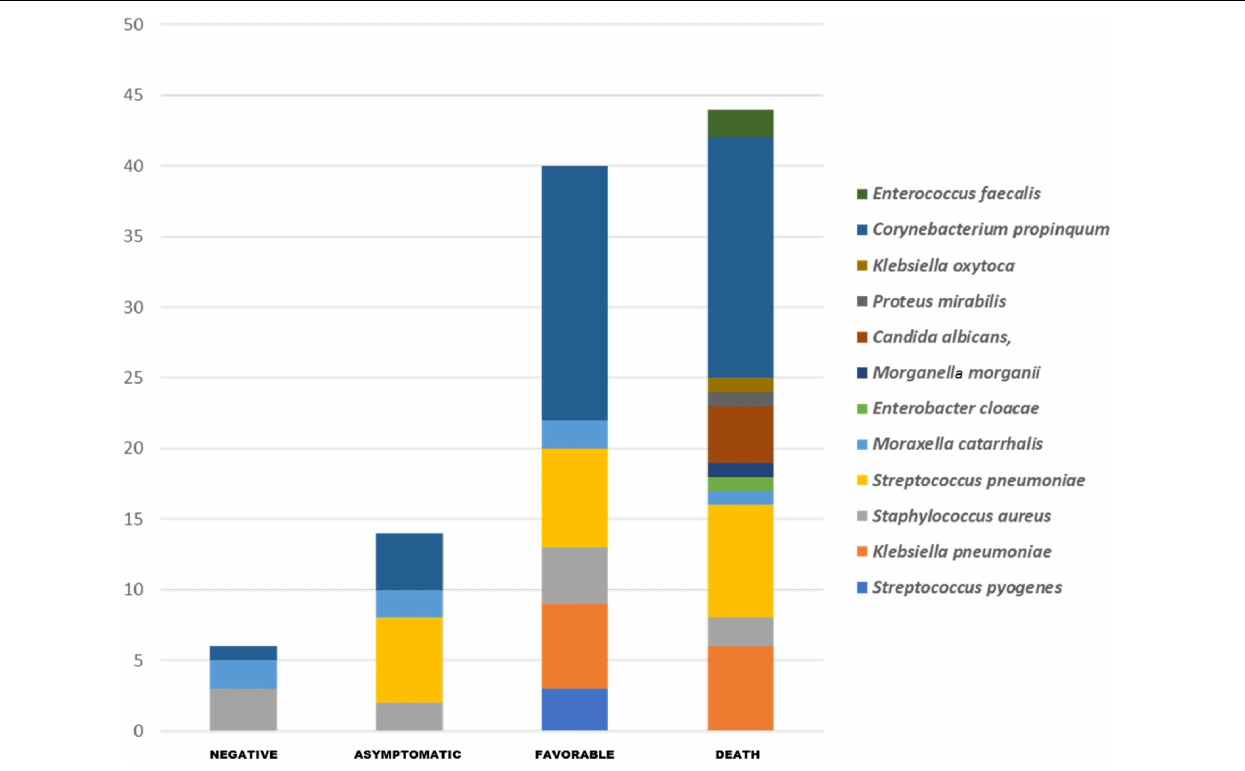
FIGURE 4 | All respiratory pathogens routinely detected in our COVID-19 patients and by specific PCR. The pathogenic bacteria PCR shows the significant enrichment of Streptococcus pneumoniae ( p ≤ 0.01) and Corynebacterium propinquum ( p ≤ 0.000006) in the group of COVID-19 positive patients, and Klebsiella pneumoniae ( p ≤ 0.01) in deceased patients and patients with a favorable outcome group compared to COVID-19 negative subjects, and Enterococcus faecalis ( p ≤ 0.05) in deceased patients compared to negative individuals. TABLE 1 | Clinical characteristics of patients with COVID-19 ( n = 90) and COVID-19 negative group. COVID-19 patients Characteristics With respiratory